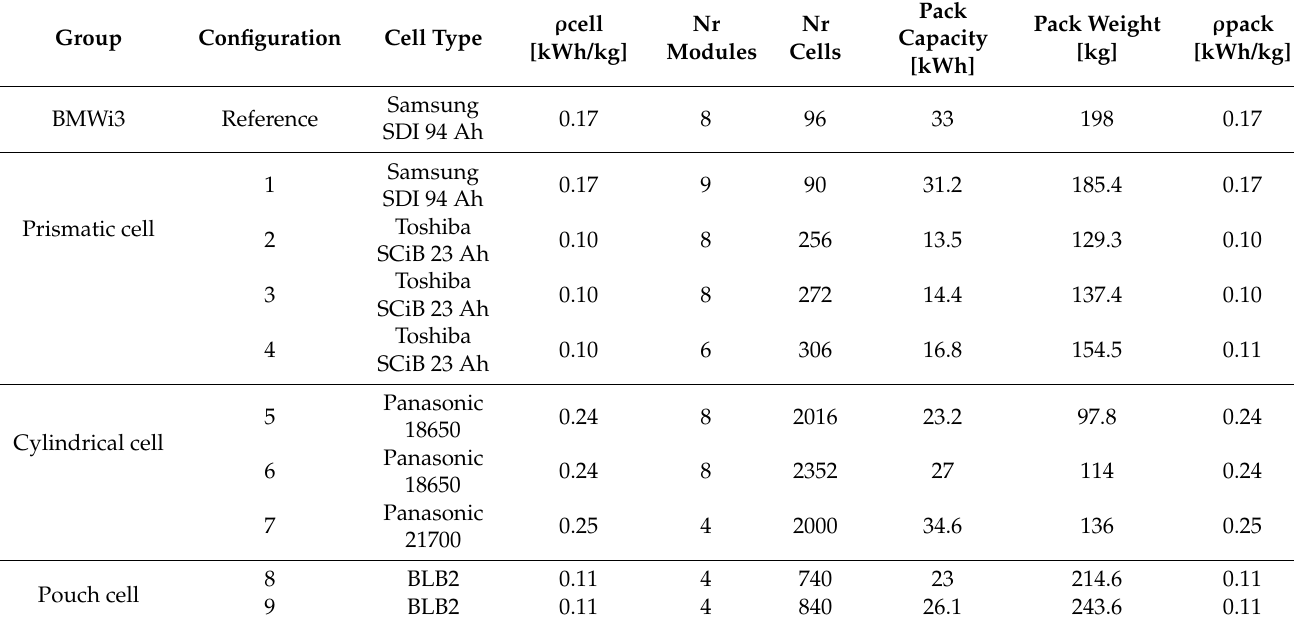
Table 4. Summary table of all pack configurations with prismatic, cylindrical and pouch cell format.